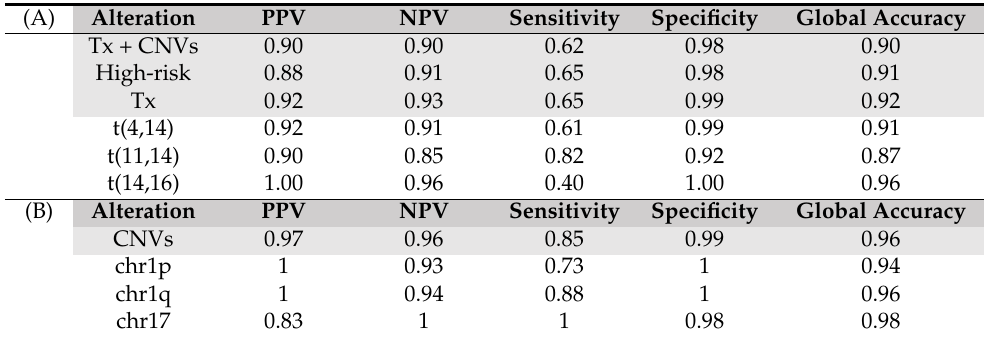
Table 2. Comparative estimators of our NGS panel against FISH and WES. (A) Estimated through comparison to FISH data. (B) Estimated through comparison to exome data. PPV = positive prognostic value, NPV = negative prognostic value. Tx =